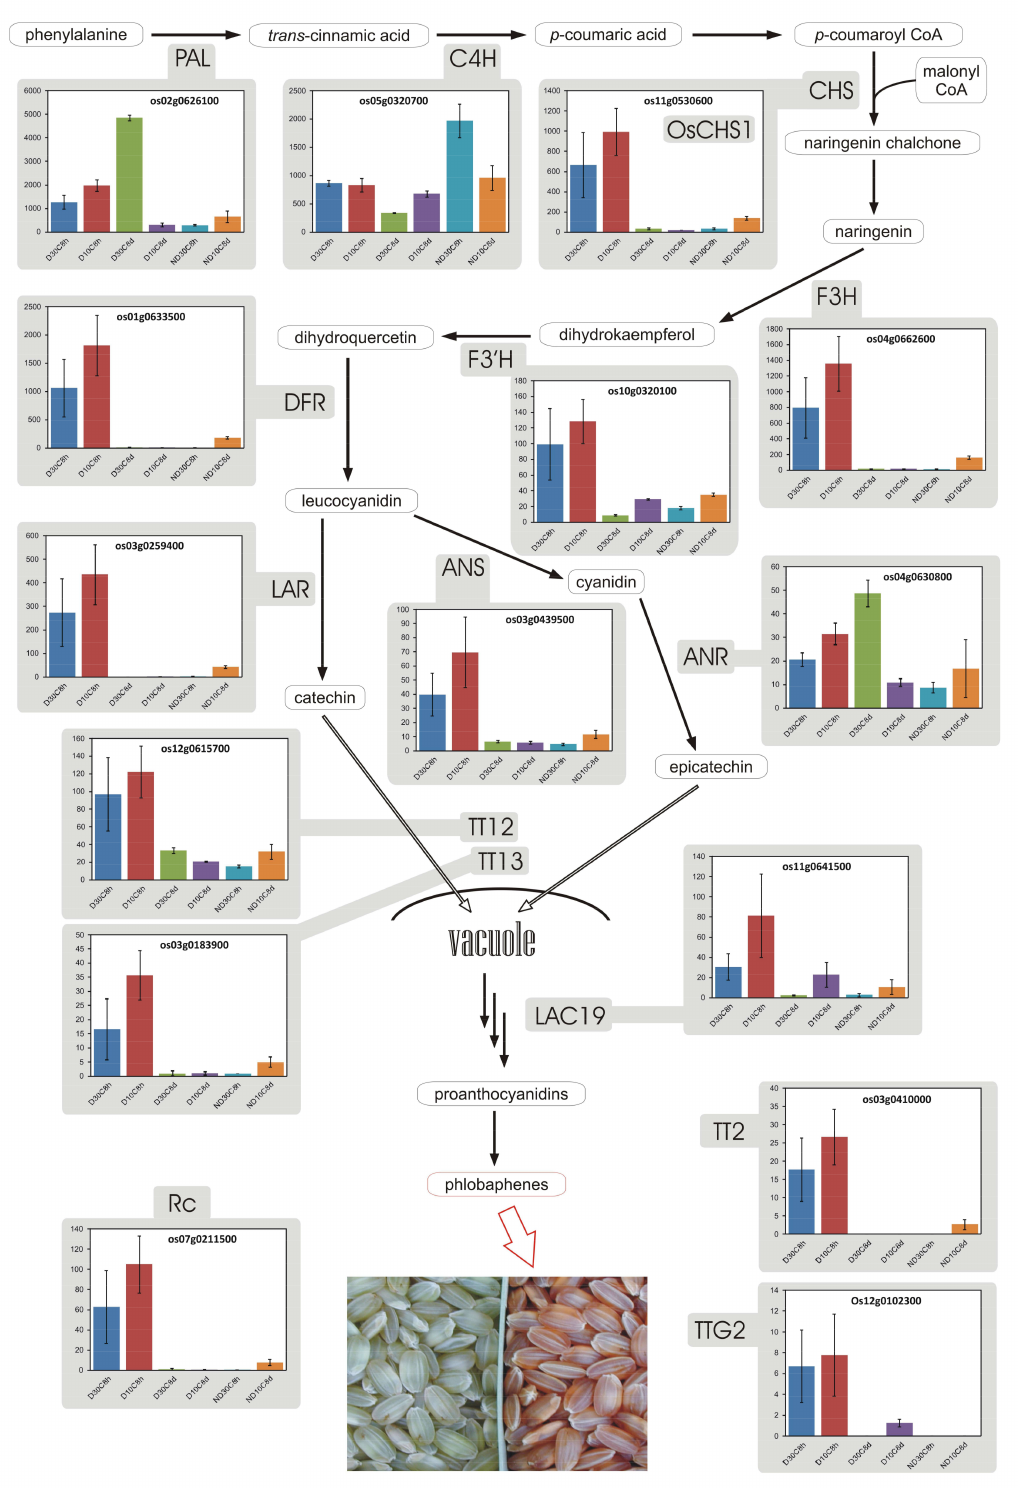
Figure 4. Expression levels (left scale on the y-axis of each plot) of DEGs involved in the proanthocyanidins biosynthesis pathway. PAL, phenylalanine ammonia lyase;